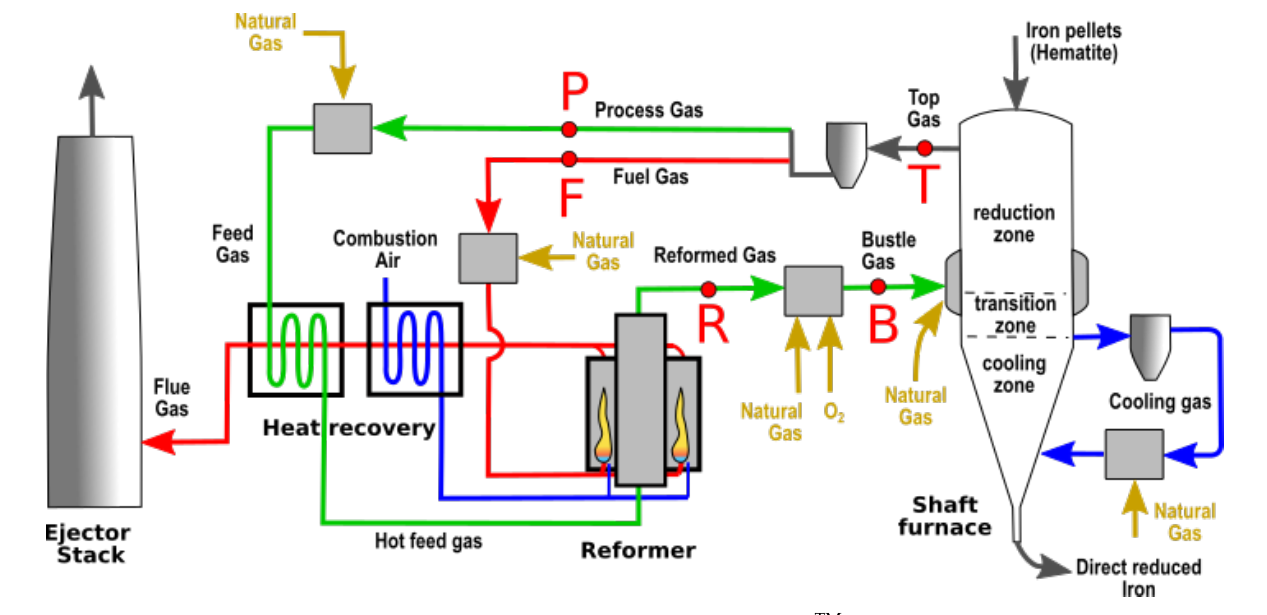
Figure 1. Operating principle of the Midrex NG TM